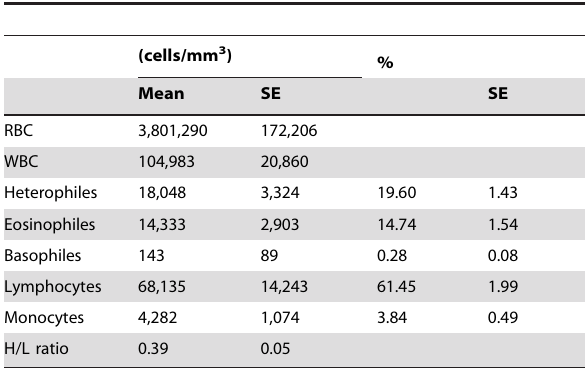
Table 1. Numbers of RBC, WBC, differential counts and H/L ratio in blood of 14 days old nestlings of spotless starling.